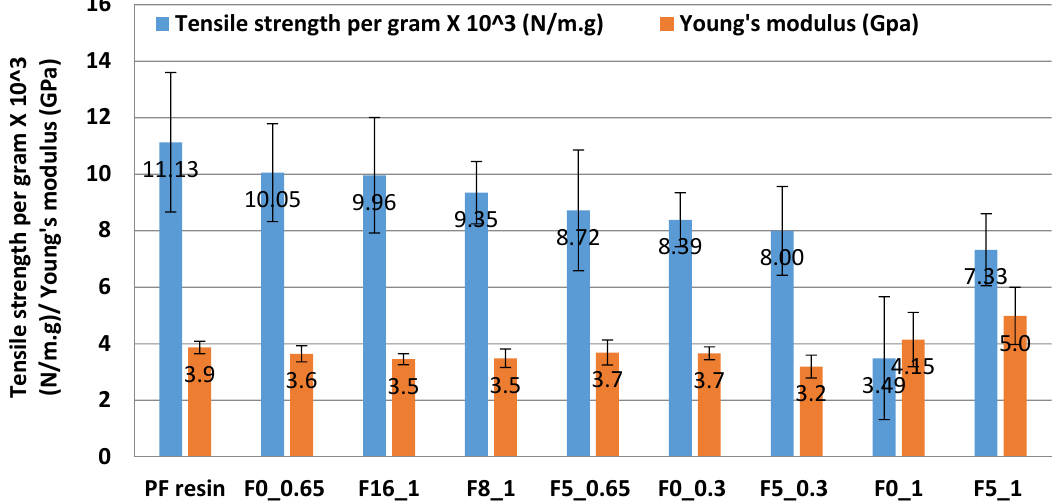
Figure 5. Effect of pH on tensile properties (tensile strength and elastic modulus) of adhesive blends at curing temperature and pressure of 180 °C and 1.9 MPa. Tensile strength per gram (N/m·g) was determined using Equation